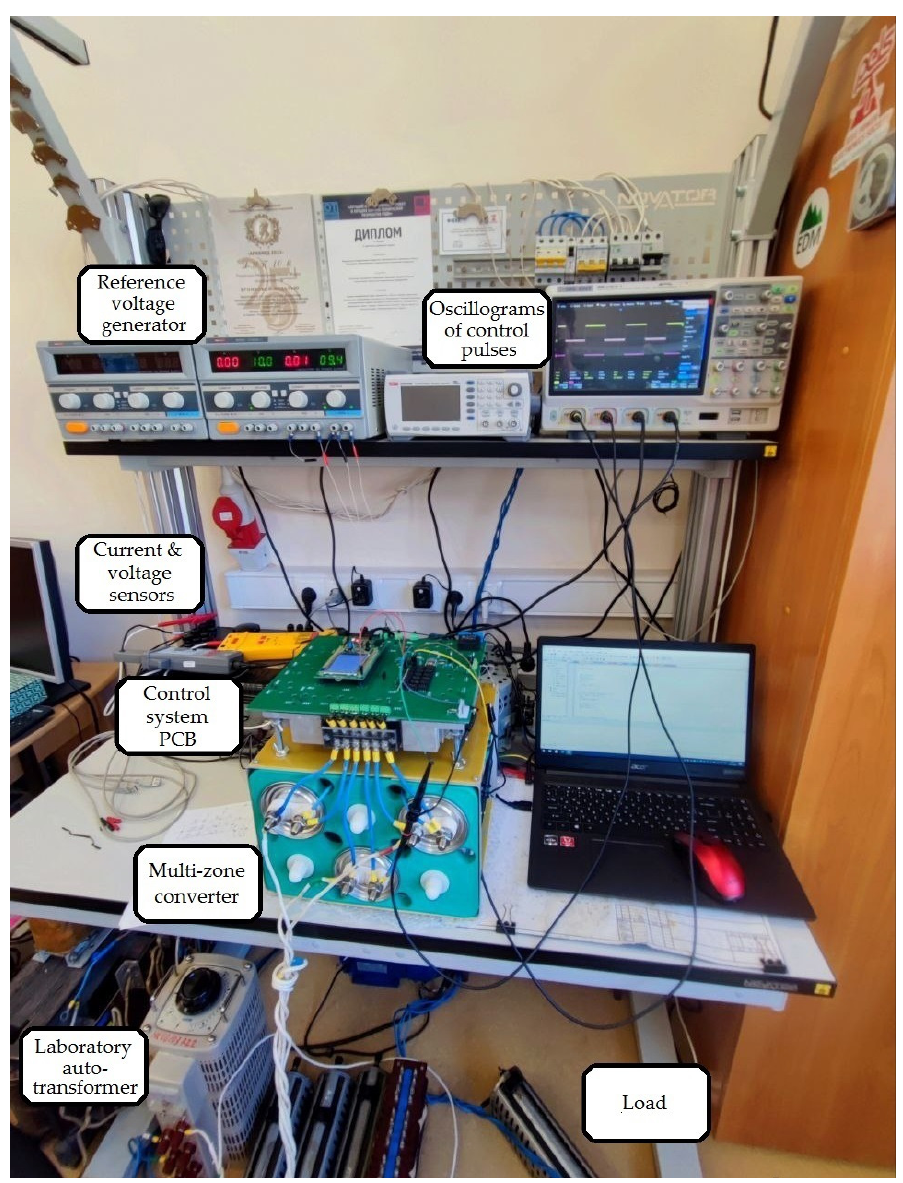
Figure 20. Photo of experimental stand.